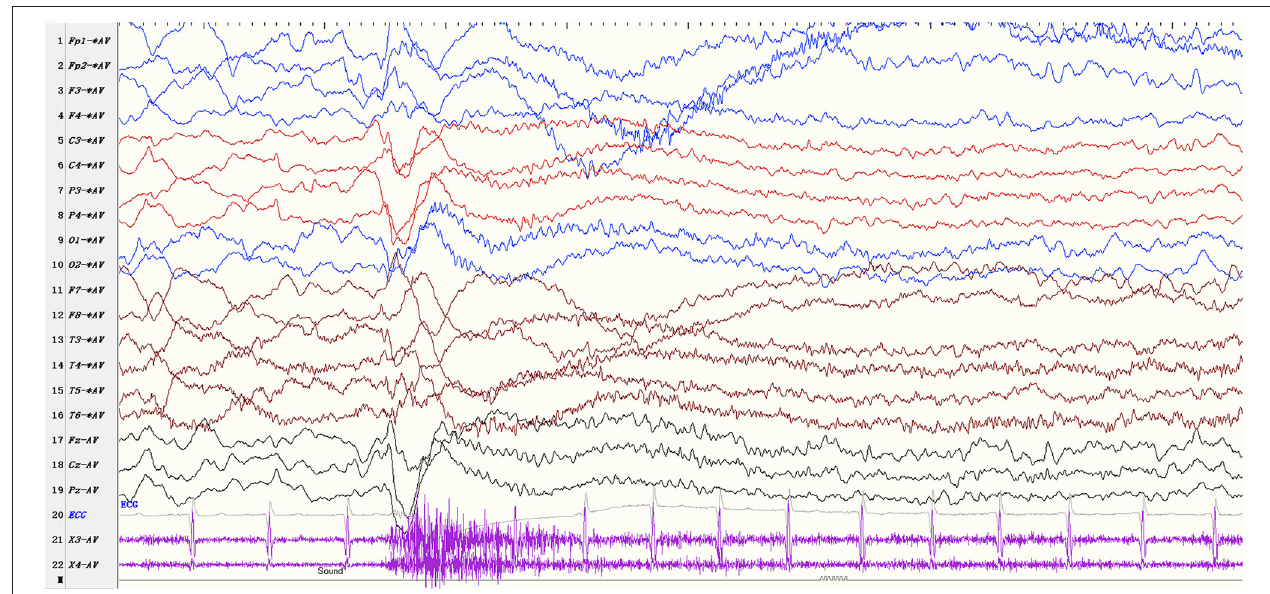
FIGURE 2 | EEG parameters: sensitivity 10 µ V/mm, high-frequency filter 70Hz, low-frequency filter 0.5Hz Startle-induced tonic-spasms (patient 10). The ictal EEG shows generalized medium-high amplitude slow waves followed by diffuse low amplitude fast rhythms and a sustained increase of the EMG activities lasting more than 10